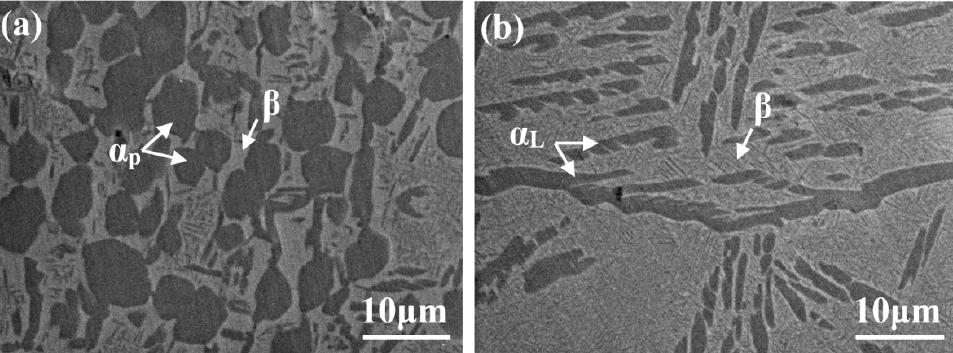
Figure 3. BSE-SEM images of samples before stretching in situ; ( a ) bimodal microstructure; ( b ) lamellar microstructure.